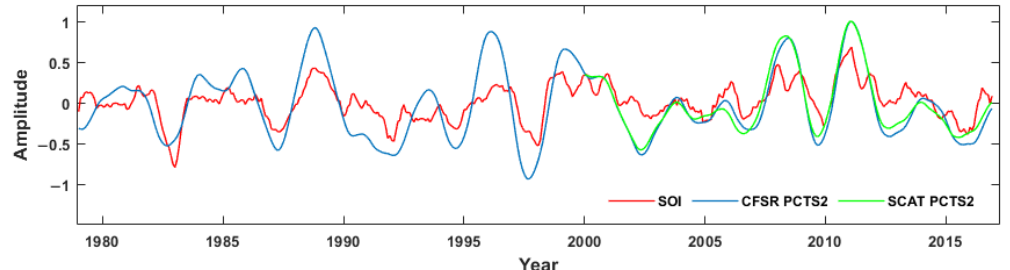
Figure 10. The PCTS of CSEOF second mode of scatterometer (green) and CSFR (blue) wind speeds. The red line denotes the time series of ENSO index SOI.